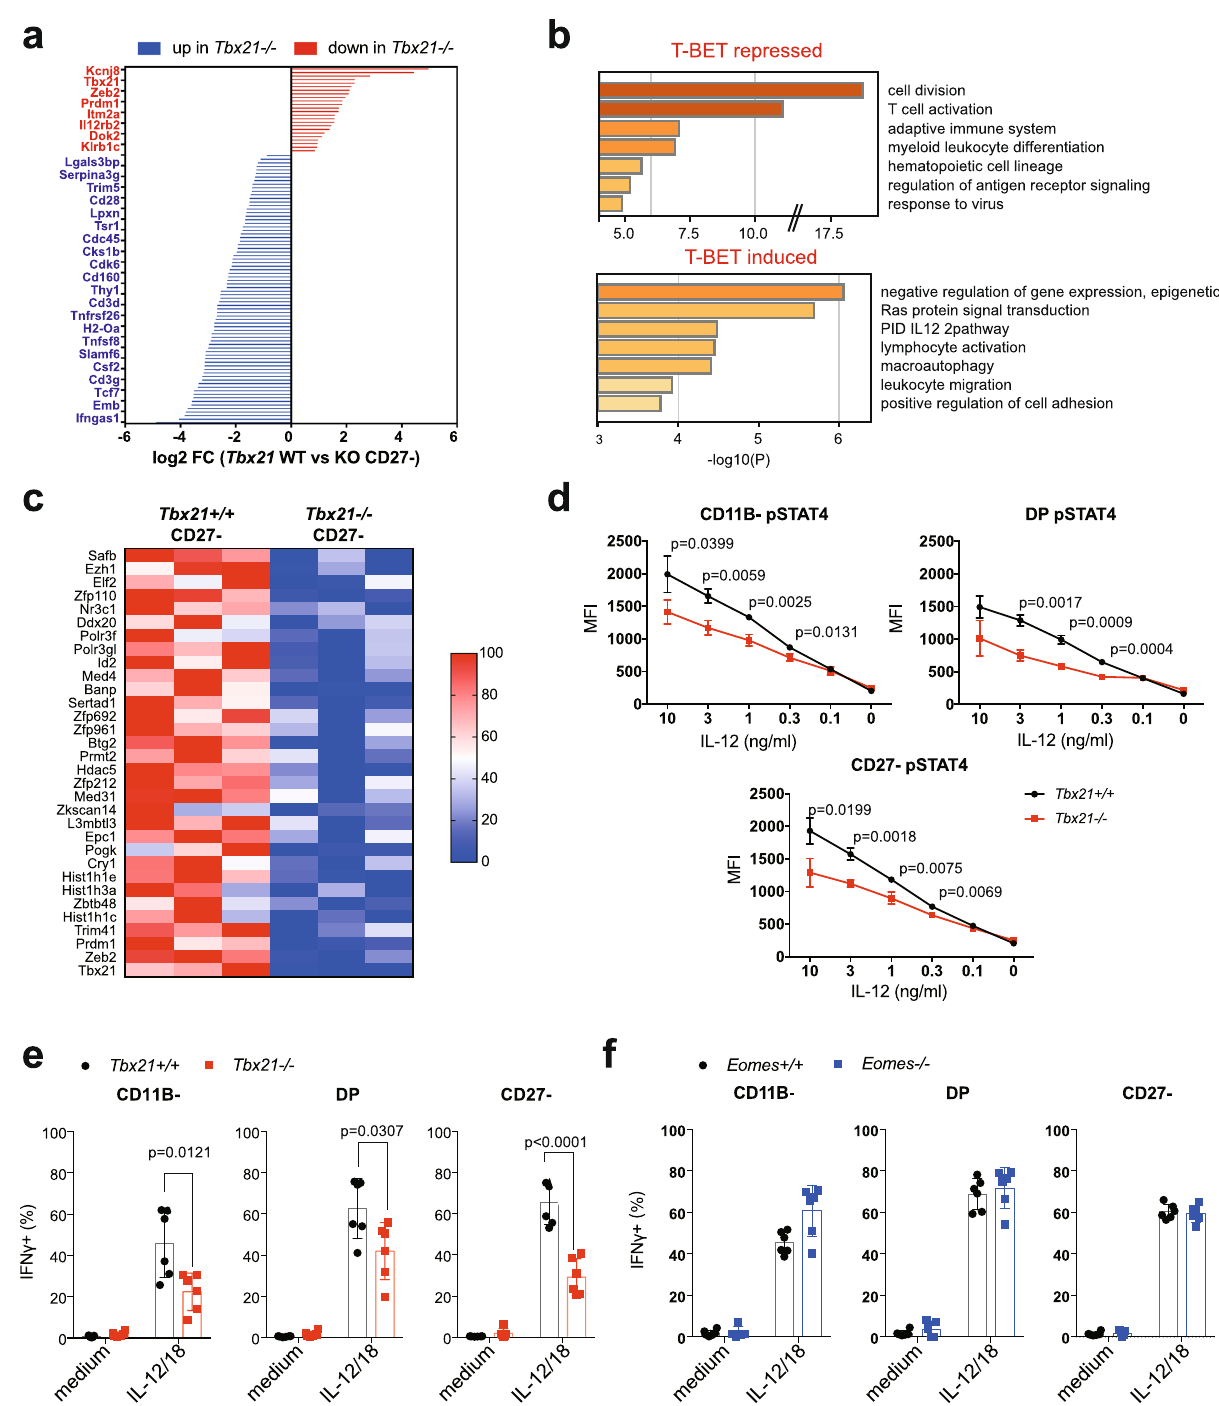
Fig. 7 T-BET-speci fi c role in the repression of pluripotency and cell proliferation. RNA-seq analysis of sorted Tbx21 − / − , Eomes − / − and appropriate control CD11B- and CD27 − NK cells ( n = 3 per group with three sorts in total). DEGs were selected based on adjusted p < 0.05. a Genes speci fi cally regulated by T-BET in mature CD27 − NK cells. Bar graphs show the log2 transformed fold change between controls and T-BET de fi cient mice, as indicated. A few selected gene names are shown. b Functional annotation of the T-BET-repressed and T-BET-induced genesets using Metascape. Bar graphs show selected terms among the most signi fi cant ones. c Transcription factors, histone subunits or histone modifying enzymes whose expression are dependent on T-BET. The heatmap shows the log2 transformed fold change in expression between control and T-BET de fi cient mature NK cells. d Flow cytometry analysis of STAT4 phosphorylation in WT vs T-BET de fi cient NK cells of the indicated subset in response to stimulation with IL-12 for 1 h. Graphs show the MFI ± SD. Data are from 3 mice representative of two experiments. e – f Flow cytometry analysis of intracellular IFN γ expression in gated spleen NK cells of the indicated genotype following culture in medium supplemented or not with IL-12 and IL-18. Bar graphs show the mean percentage of IFN γ positive NK cells ± SD. N = 6 mice in 2 experiments. Unpaired t tests (two-tailed) were used for statistical analysis of data presented in this fi gure.